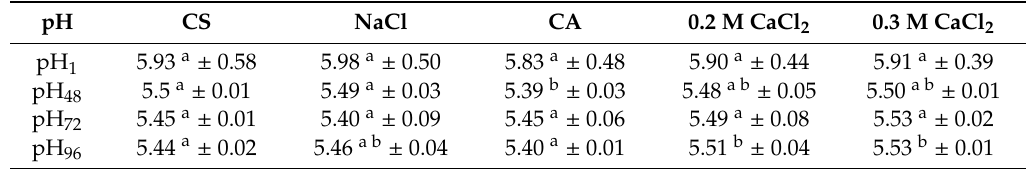
Table 1. Changes in pH value of horse meat during cold storage ( x ± S).